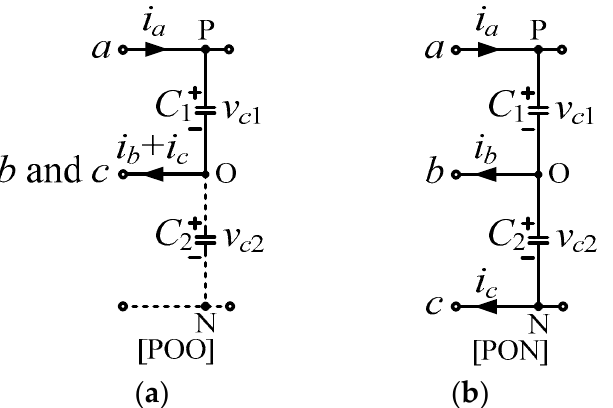
Figure 3. Capacitor current flow of sector 1 with switching status: ( a ) (POO); ( b ) (PON).